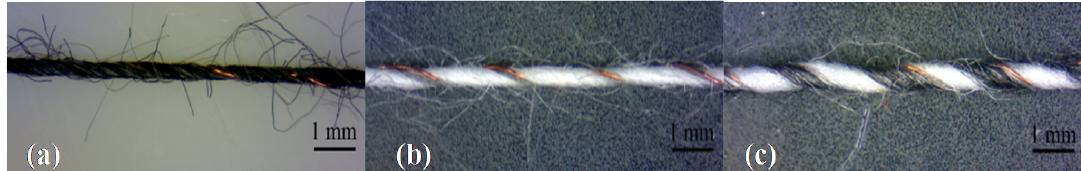
Figure 6. Stereomicroscopic observations of BC ( a ); PC ( b ) and BPC ( c ) ring-spun complex yarns.